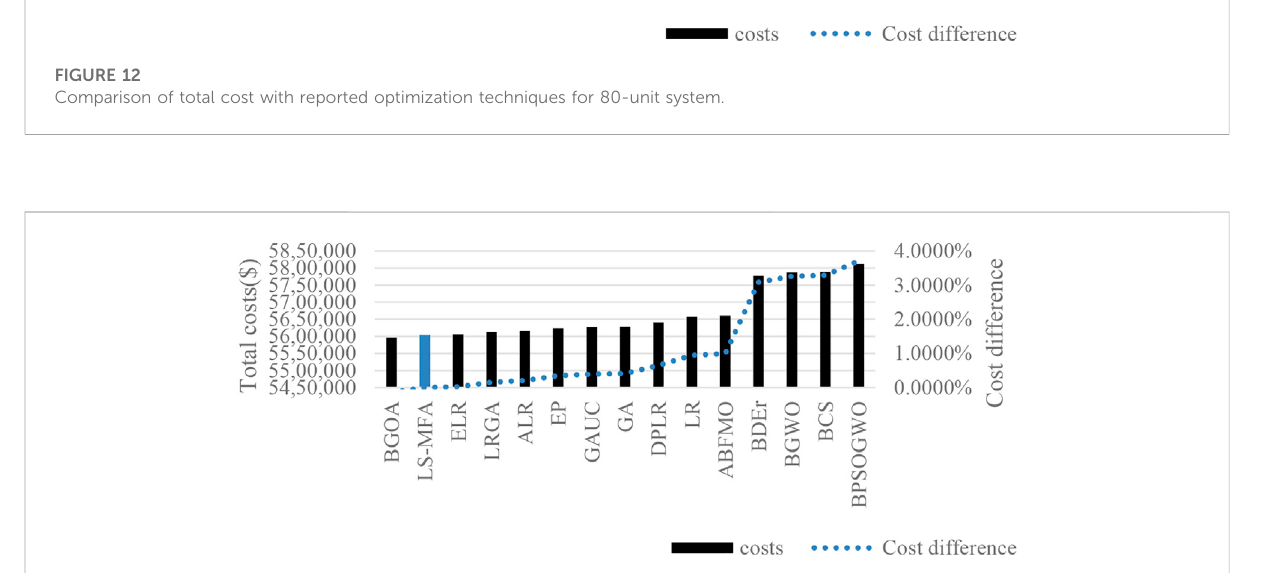
FIGURE 13 Comparison of total cost with reported optimization techniques for 100-unit